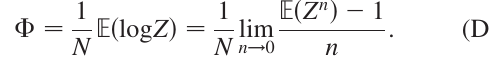
; F ; criterium ; t (cid:6) (cid:6)i